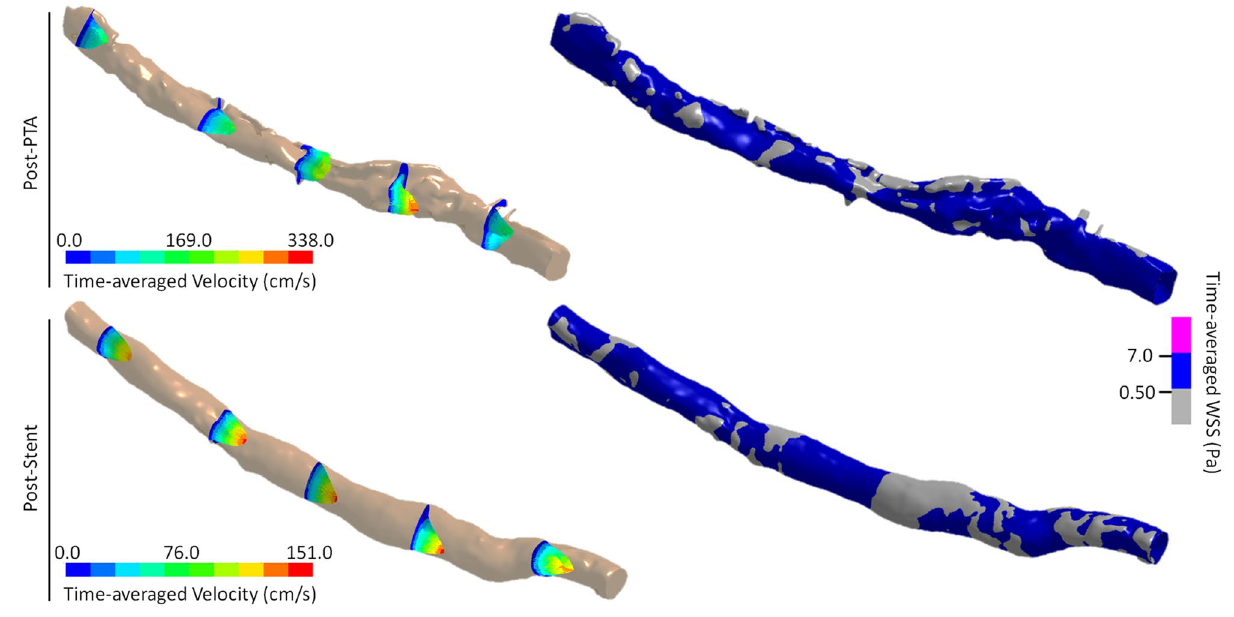
Figure 4. The development of time-averaged flow velocity and distribution of time-averaged Wall Shear Stress (WSS) in an artery (P5) following PTA and Nitinol stent implantation. As is the case with P3, the majority of the areas affected by low TAWSS is concentrated at arterial dissections, where the flow velocity is significantly lower than the rest of the artery. Following stenting, the dissected tissues are pushed towards the lumen wall and the velocity profile affected by diameter changes and the tortuosity of the artery. (Generated by LS-DYNA R10.1, http:// www. lstc. com/ produ cts/ ls-